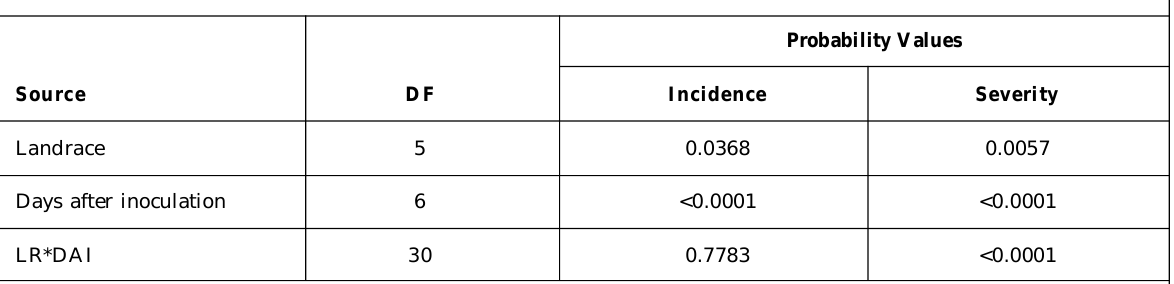
Probability Values